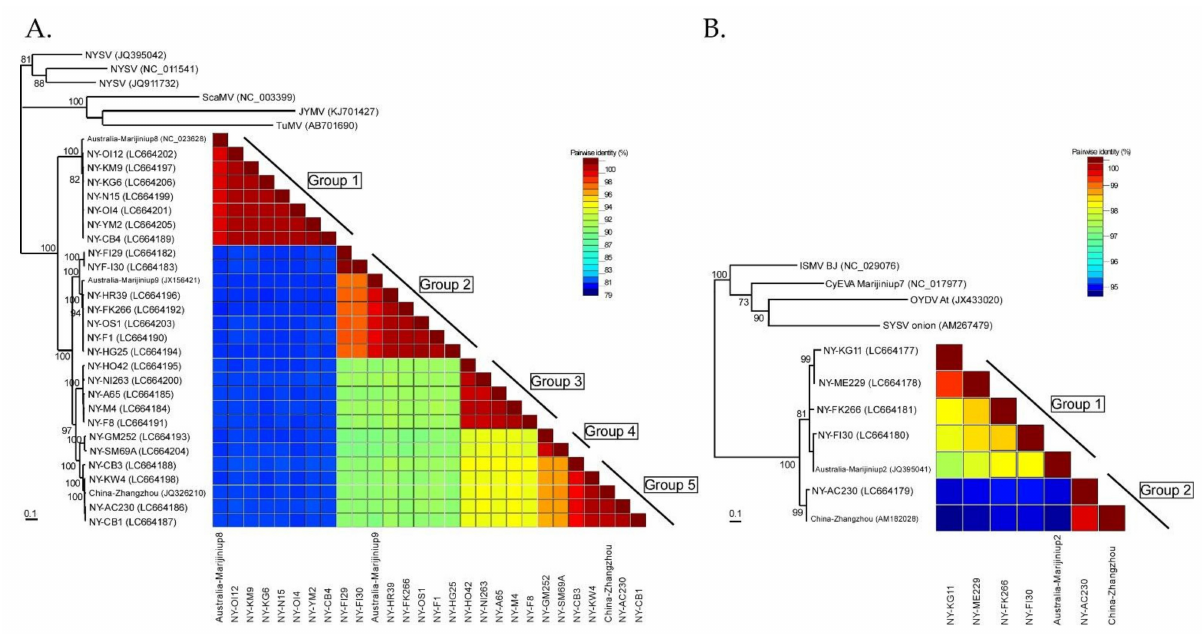
Figure 4. Phylogenetic relationships and pairwise identities of two narcissus viruses. ( A ) Twenty- eight partial polyprotein coding sequences (genome position nt 2076–7471) of narcissus late season yellows virus (NLSYV) were used to infer maximum likelihood phylogenetic trees. The polypro- tein coding sequences of Japanese yam mosaic virus (JYMV) [46], narcissus yellow stripe virus (NYSV) [23,26,27], scallion mosaic virus (ScaMV) [48], and turnip mosaic virus (TuMV) [47] in the TuMV phylogenetic group were used as outgroup taxa. ( B ) Seven complete polyprotein coding se- quences of narcissus degeneration virus (NDV) were used to infer maximum likelihood phylogenetic trees. The polyprotein coding sequences of cyrtanthus elatus virus A (CyEVA) [27] (acc # NC_017977), iris severe mosaic virus (ISMV) [49] (acc # NC_029076), onion yellow dwarf virus (OYDV) [50] (acc # JX433020), and shallot yellow stripe virus (SYSV) [51] (acc # NC_007433) in the OYDV phylogenetic group were used as outgroup taxa for NDV. Number at each node indicate bootstrap percentages based on 1000 pseudoreplicates for both trees and the values >70% are only